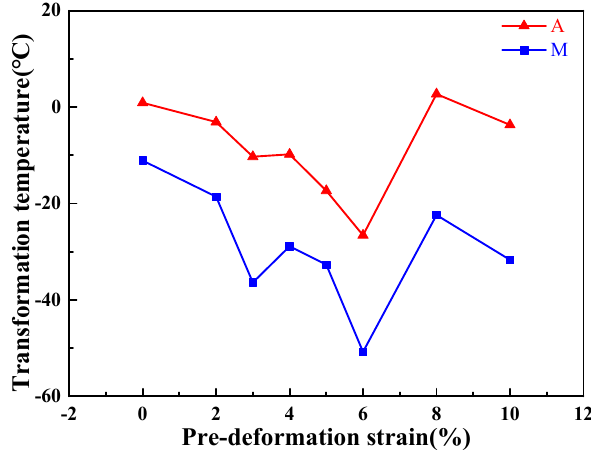
Figure 12. Transformation temperatures on DSC samples after different cryogenic pre-deformations. Note: A = ( A s + A f )/2; M = ( M s + M f